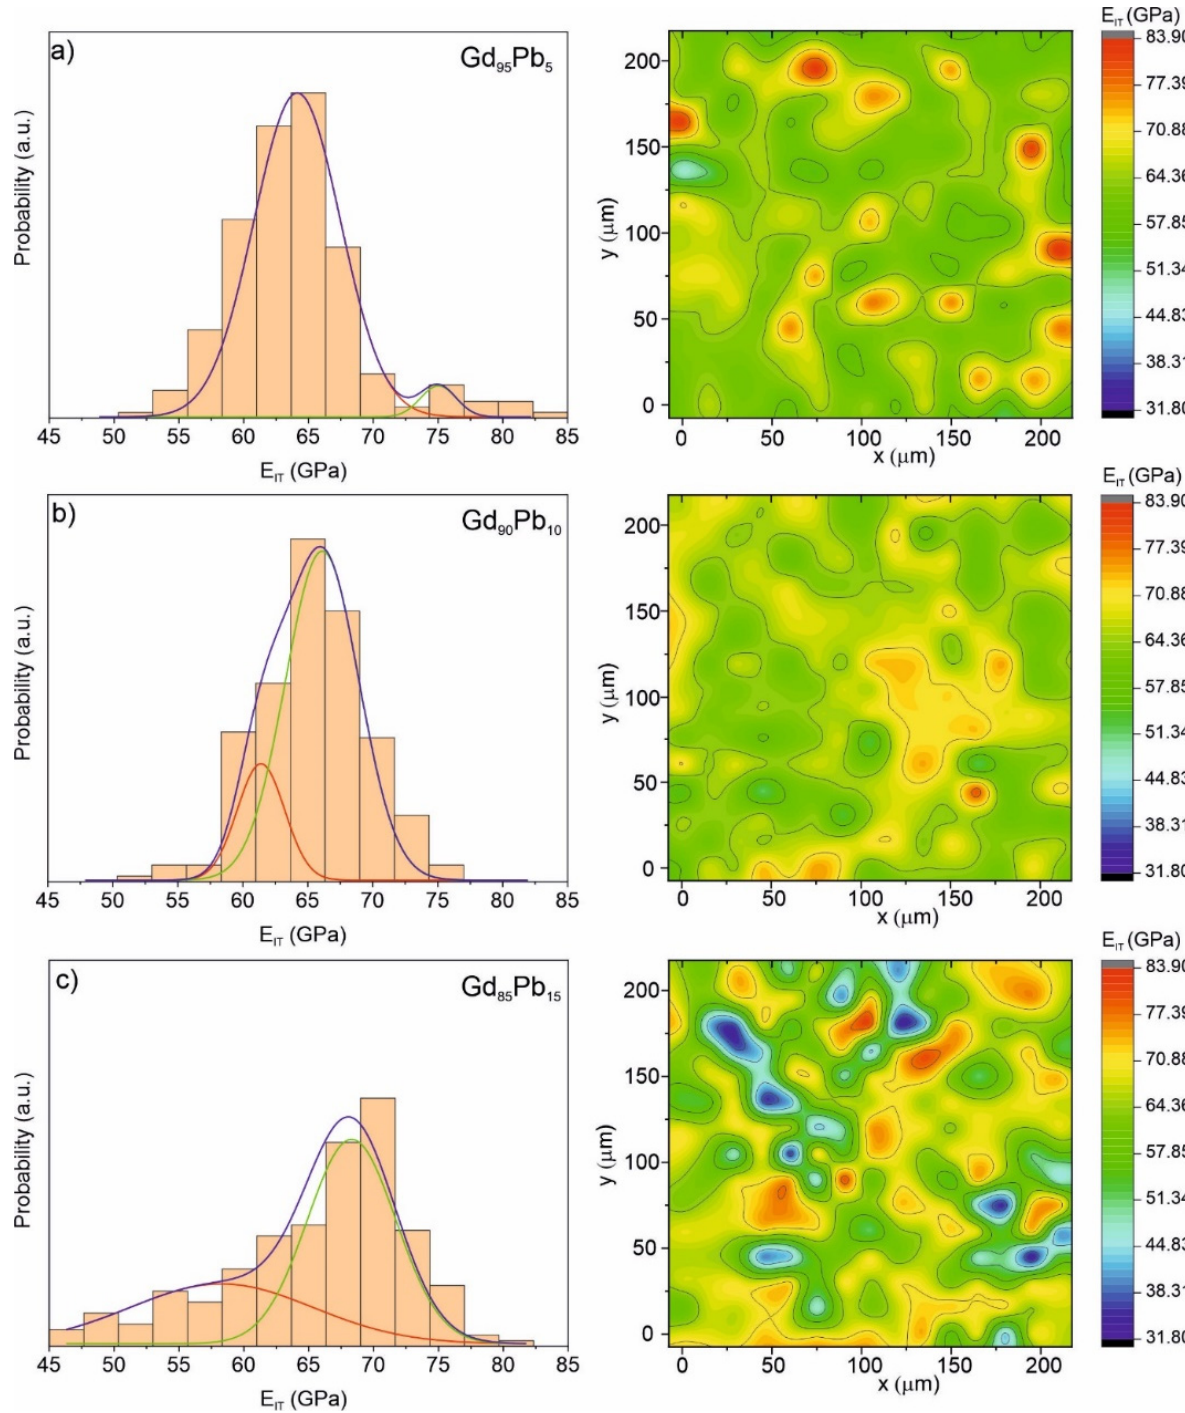
Figure 9. Distributions of Young’s modulus E IT with corresponding 2D mapping graphs obtained from nanoindentations test for the Gd 95 Pb 5 ( a ), Gd 90 Pb 10 ( b ) and Gd 85 Pb 15 ( c ) alloys.